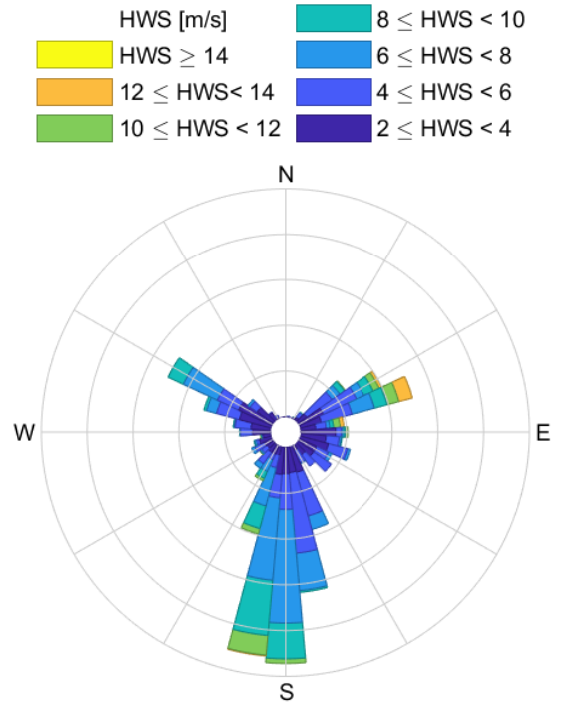
Figure 6. Wind rose representing the HWS and WD (after data filtering), measured during the PdP campaign, by the reference LiDAR (10 min) from June 6 to June 30 of 2013 (1875 records). During the night, the wind was light, coming predominantly from the urban area (NW), showing low HWS values with high turbulence and spatial variability. During the day, the atmosphere was dominated by winds coming from the sea towards land (S and NE), with higher HWS and lower